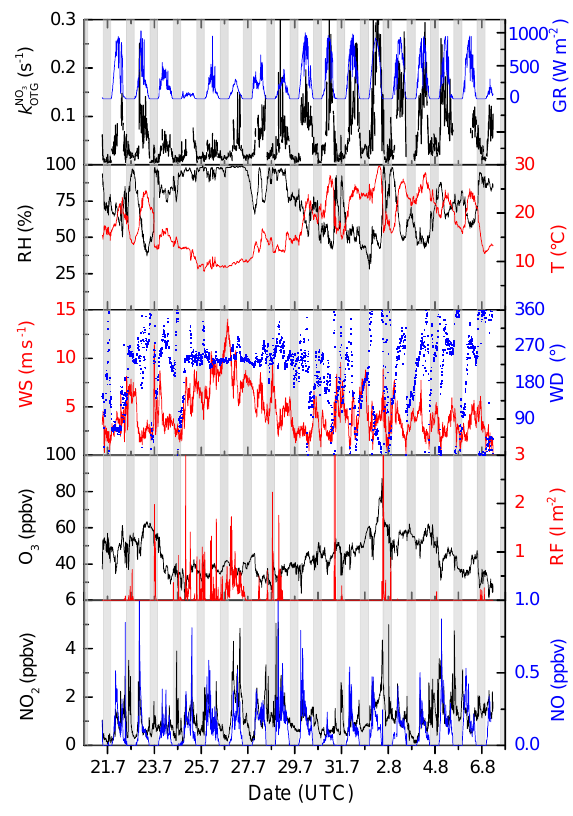
Figure 1. Overview of measurements during the 2017 intensive. The grey shaded area represents night-time. GR: global radiation, RF: rainfall, RH: relative humidity, T : temperature, WS: wind speed, WD: wind